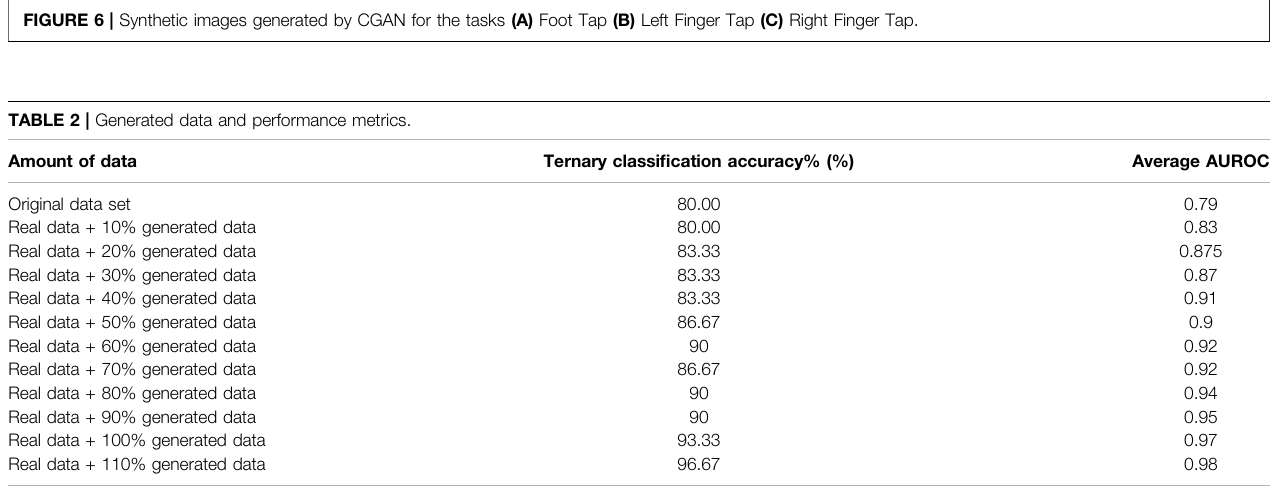
FIGURE 6 | Synthetic images generated by CGAN for the tasks (A) Foot Tap (B) Left Finger Tap (C) Right Finger Tap.